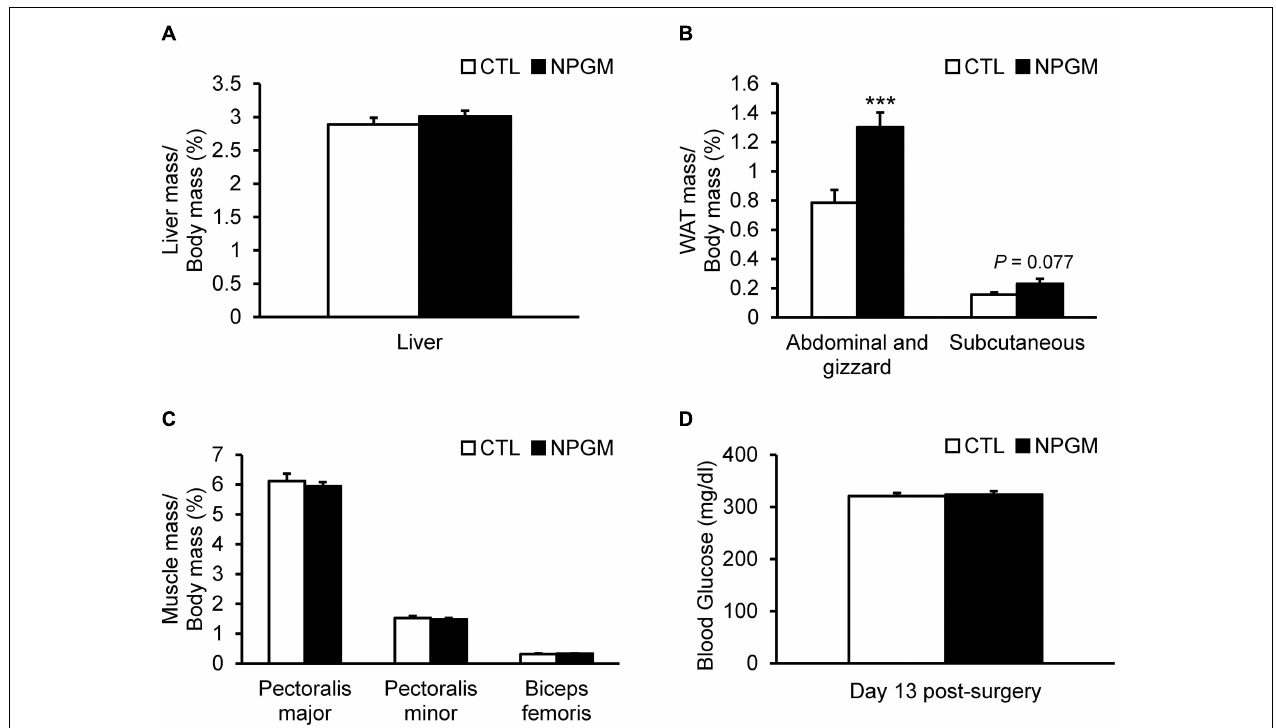
FIGURE 2 | Effect of chronic i.c.v. infusion of NPGM on body composition. The results were obtained by the infusion of the vehicle (control; CTL) and NPGM for 2 weeks. Ratio of the liver mass/body mass (A) , ratio of the abdominal and gizzard fat mass/body mass, and the subcutaneous fat mass/body mass (B) , ratio of pectoralis major, pectoralis minor, and biceps femoris muscle masses/body mass (C) , and blood glucose level (D) were measured at the end of the experiment. Data are expressed as the mean ± SEM ( n = 7–8). Data were analyzed by the Student’s t -test. Asterisks indicate statistically significant differences (*** P < 0.005).